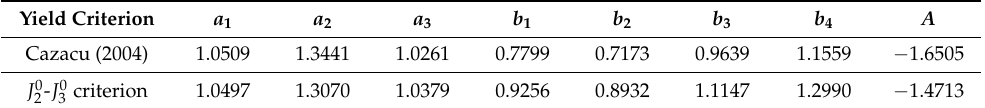
Table 2. Anisotropic and tension–compression asymmetry parameters of the J 0 Cazacu–Barlat criterion for Cu-Al-Be SMA at 35 ◦ C.